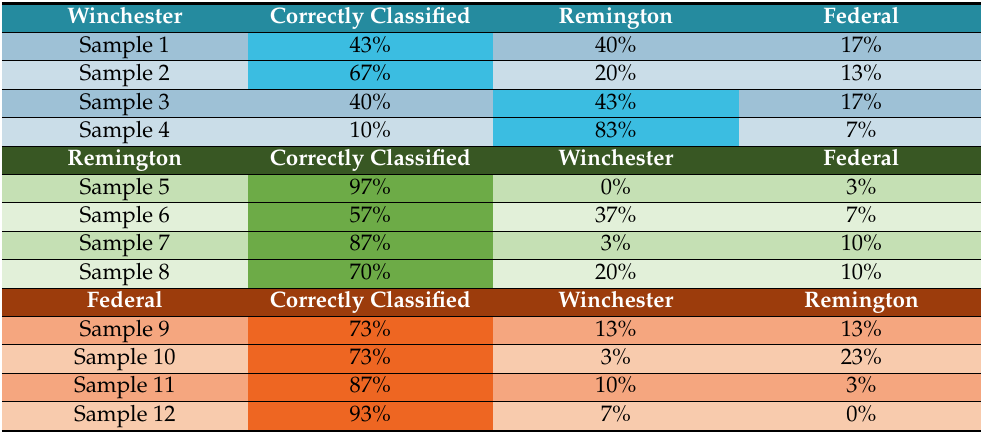
Table 3. Smokeless powder manufacturer differentiation model results shown in percentages. Highest percentages showing the class assignments for each sample are highlighted in bright colors.